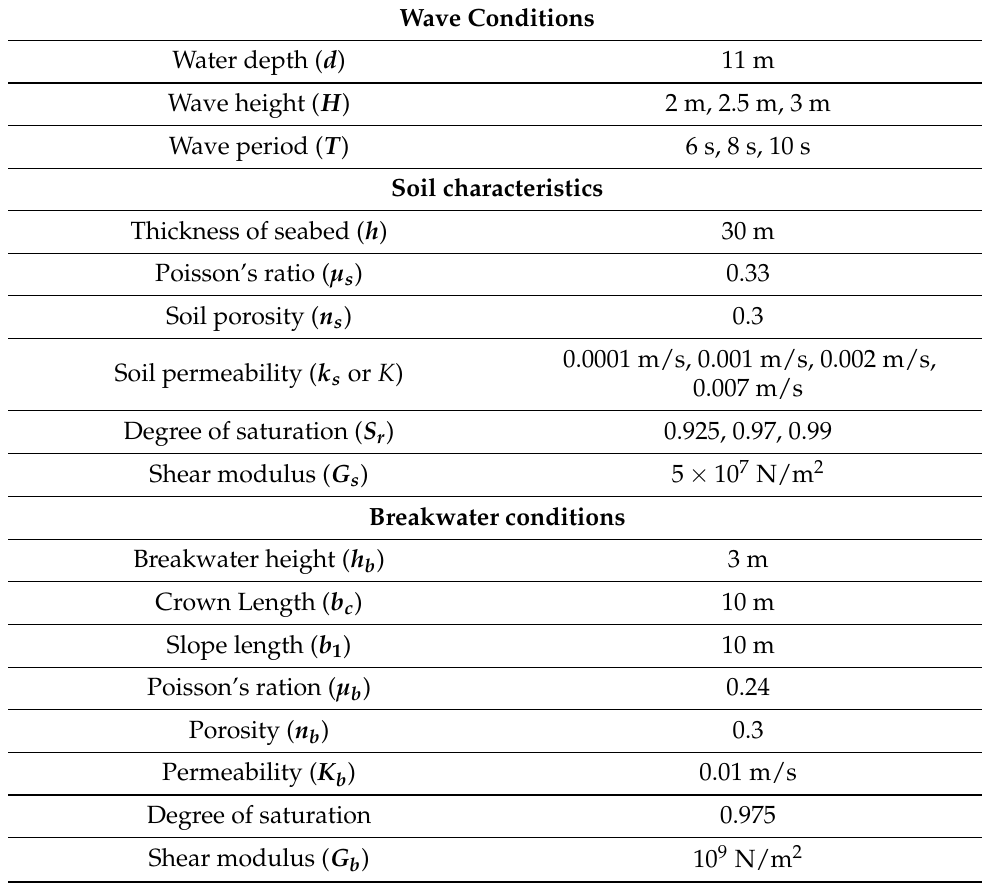
Figure 3. Schematic configuration of computational domain with a breakwater. Table 2. Input data for numerical examples with regular wave